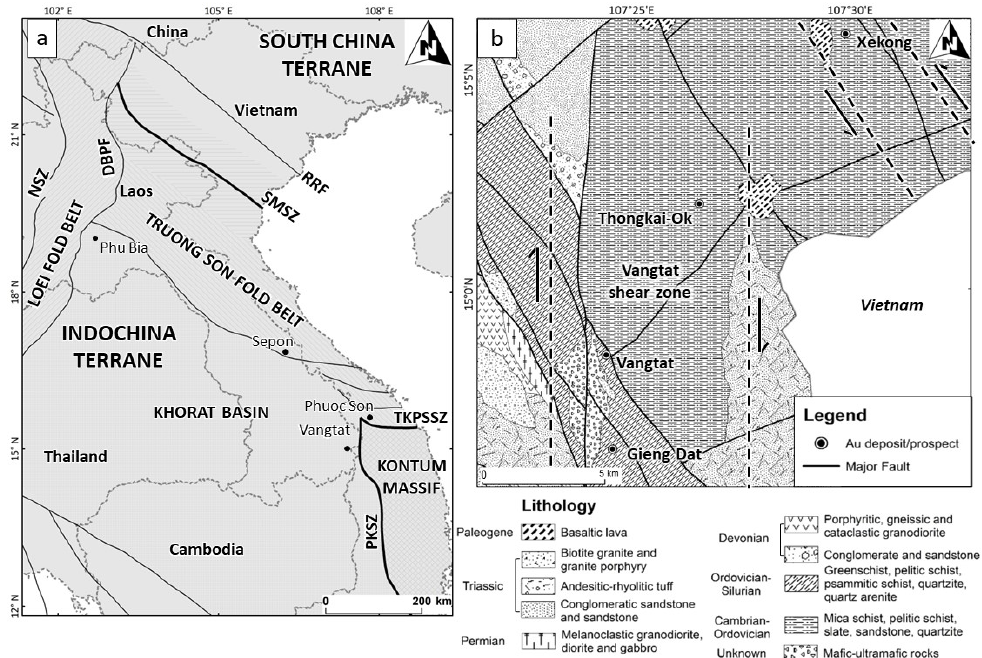
Figure 1. ( a ) Main tectonic terranes and domains of mainland Southeast Asia, and associated metal deposits (mod. From Lepvrier et al. (2008) [17]). Abbreviations: DBPF: Dien Bien Phu Fault; NSZ: Nan Suture Zone; PKSZ: Poko Suture Zone; RRF: Red River Fault; SMSZ: Song Ma Suture Zone; TKPSSZ: Tam Ky-Phuoc Son Suture Zone. ( b ) Geological map of the Vangtat shear zone, southeastern Laos, and the distribution of Au deposits (Bounliyong et al. (2021) [9]; after Vilayhack et al. (2008) [18]). The black dashed lines roughly mark the boundaries of the shear zones.